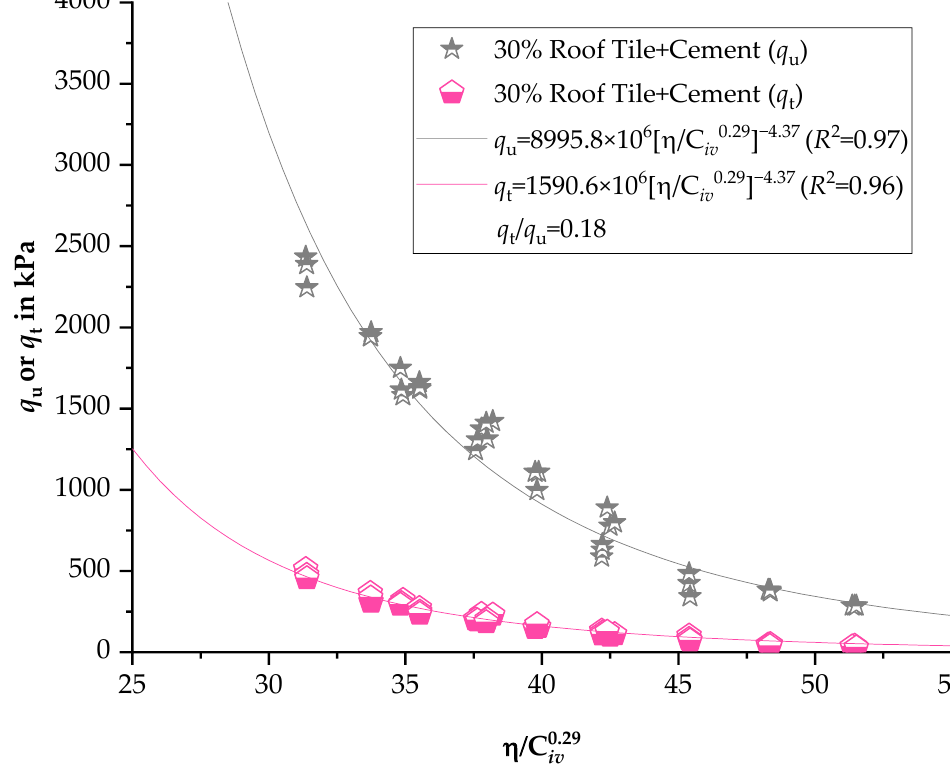
Figure 4. Variation of q u and q t with the porosity/volumetric cement ratio (using the exponent b = 0.29) for 30% of roof tile waste.